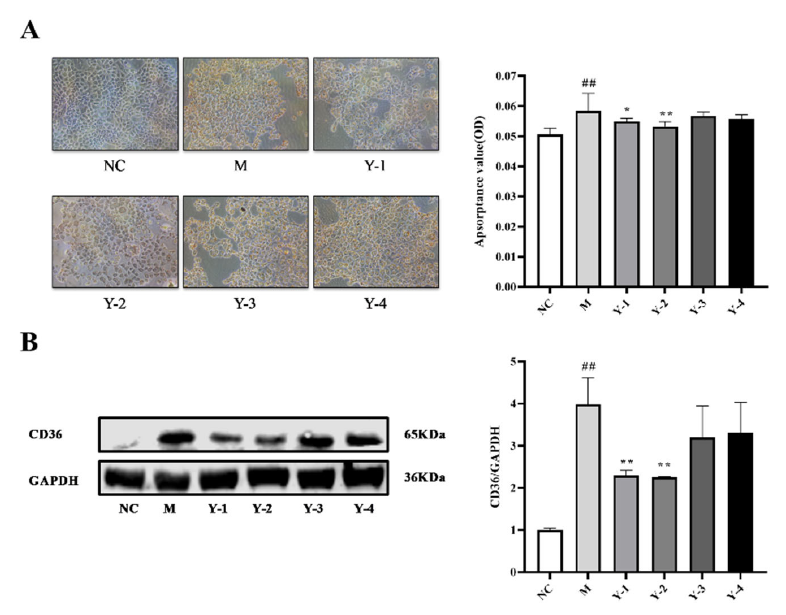
Figure 2. Effects of phenolic compounds from Mori Cortex on NRK-52e cells’ lipid deposition stimulated by sodium oleate. Effect of sodium oleate on lipid accumulation in NRK-52e cells detected by Oil Red O staining ( A ). The expression of CD36 protein in NRK-52e cells were quantified by Western blot and normalized ( n = 3) ( B ); ## p < 0.01 compared with NC group, * p < 0.05, ** p < 0.01 compared with M group.